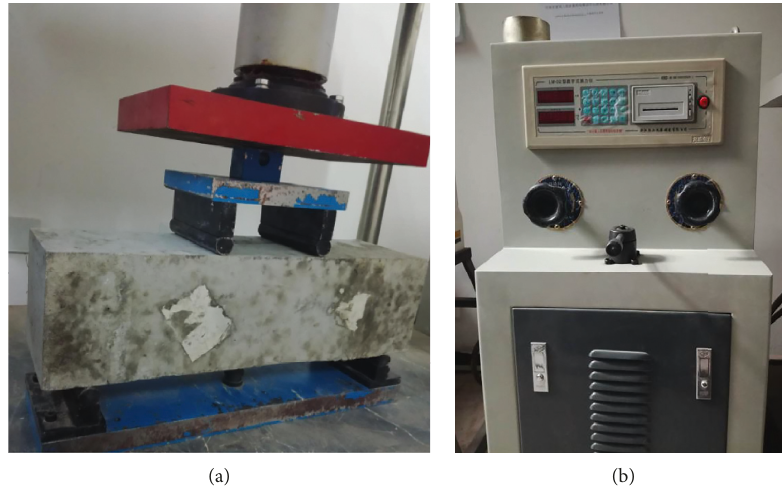
Figure 6: Flexural tensile strength test apparatus.